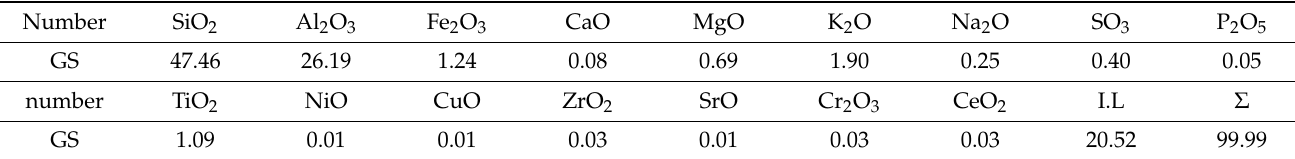
Table 1. Chemical composition analysis of coal gangue (w/%).